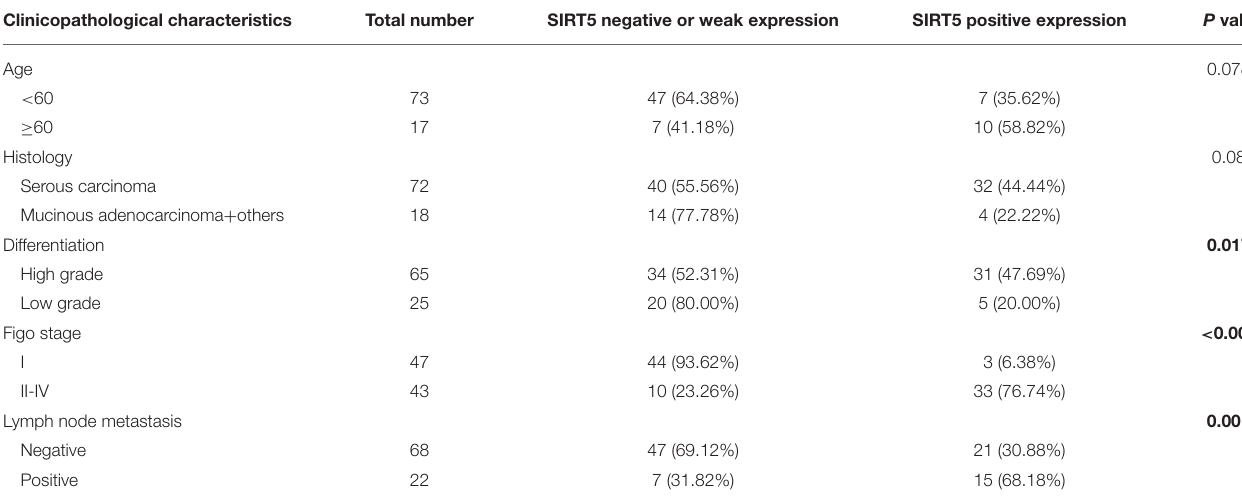
TABLE 1 | Association of SIRT5 expression with clinicopathological characteristics of ovarian cancer tissue